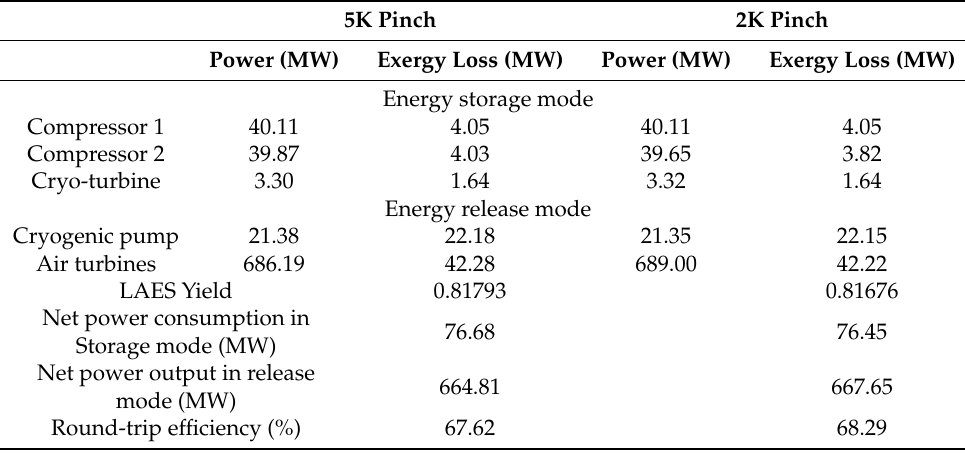
Table 6. Performance summary for 5K pinch (left) and 2K pinch (right).